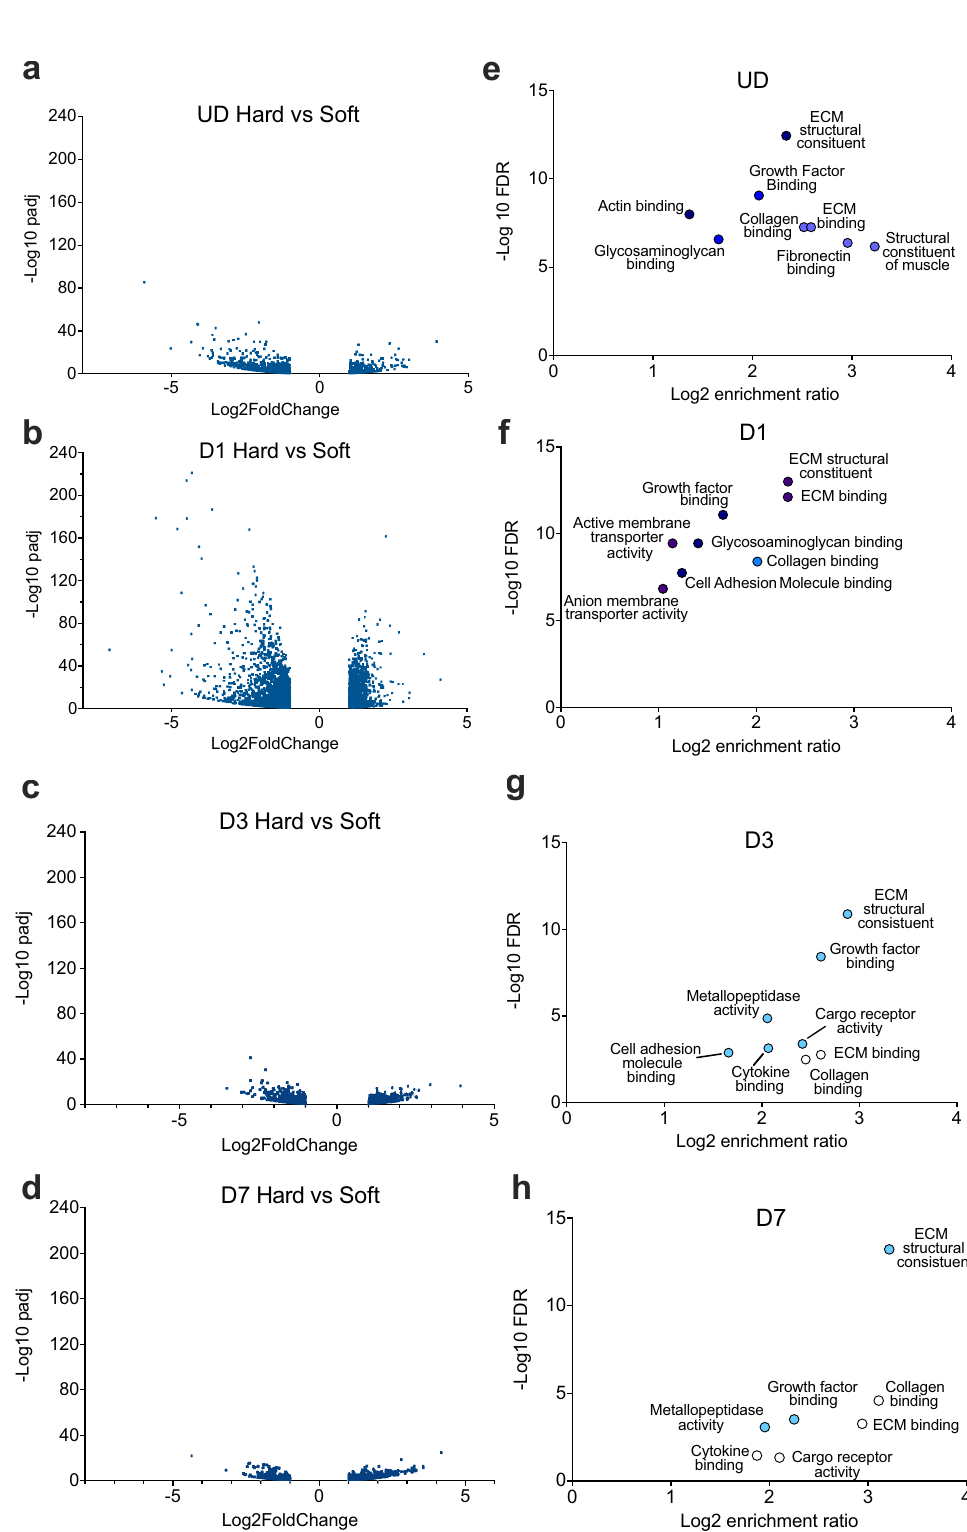
Figure 2. Global comparison of changes in gene expression levels at each time point between C1F cells cultured on hard or soft surfaces. ( a–d ) Shows volcano plots for gene expression where the log 2 fold change is either > 1 or < − 1, and where the padj is < 0.05 (− log10 padj > 1.3). ( e–h ) Shows the overrepresented GO (Gene Ontology) terms with false discovery rate (FDR) < 0.05 from a WebGestalt analysis for differentially-expressed-genes between hard and soft surface samples. The symbol colour for each gene set is approximately related to the number of enriched genes within each gene set from dark blue (> 100) to white (<